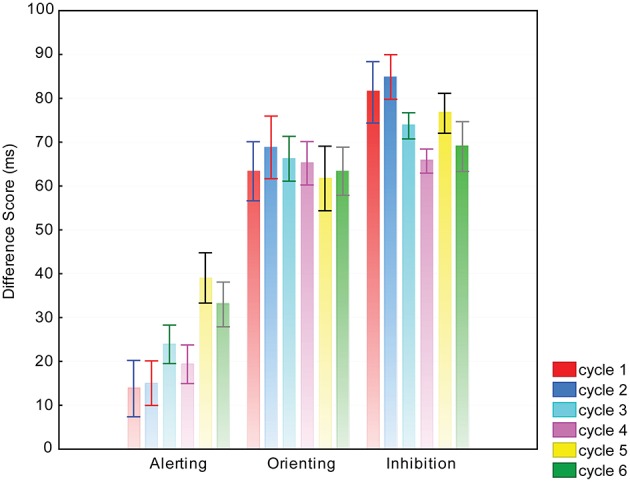
Mean difference scores and standard errors for each of the three attention networks and six cycles. Attention network effects were calculated as reaction time differences of the following conditions: alerting = RTnocue − RTcentercue; orienting = RTcentercue − RTspatialcue, inhibition = RTincongruent − RTcongruent.